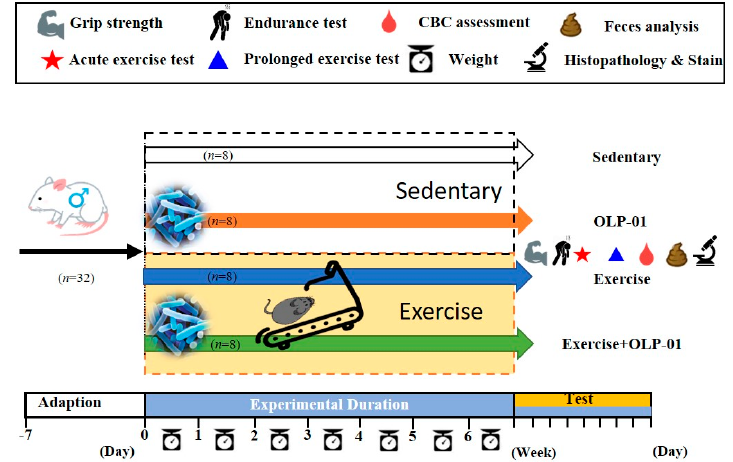
Figure 1. Experimental design to examine the effects of exercise and probiotics on exercise adaption. The animals were randomly assigned to the indicated four groups (sedentary, OLP-01, exercise, and exercise + OLP-01). Physical fitness and related assessments were conducted during the test.